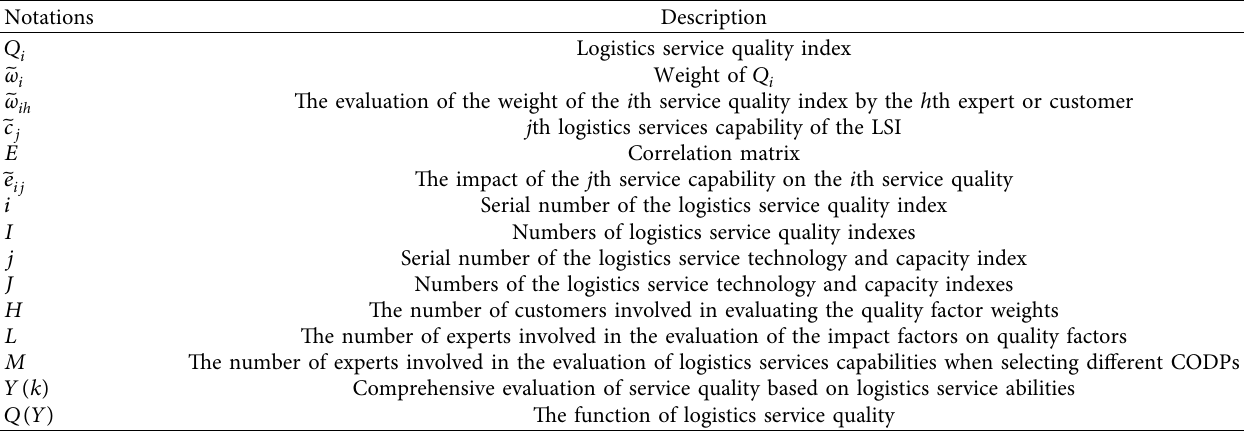
Table 5: Notations for Fuzzy QFD model.